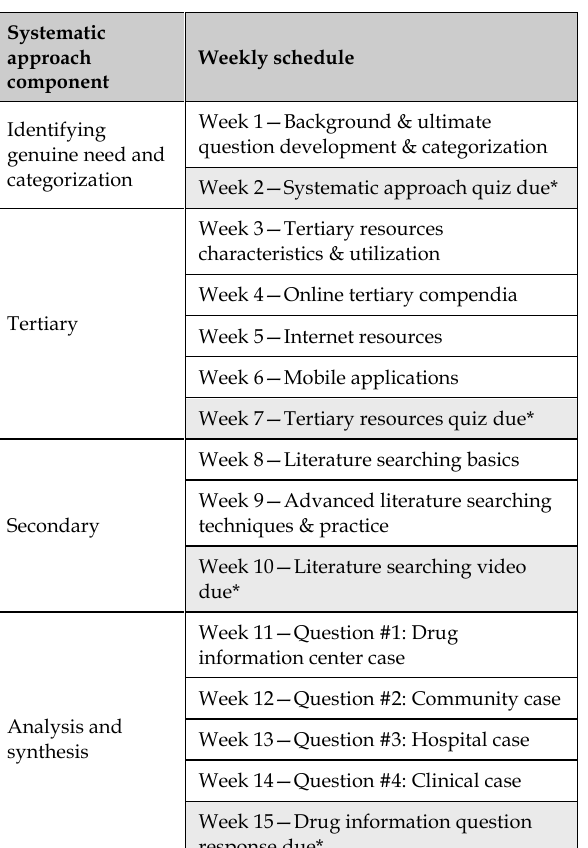
Table 1 Course schedule